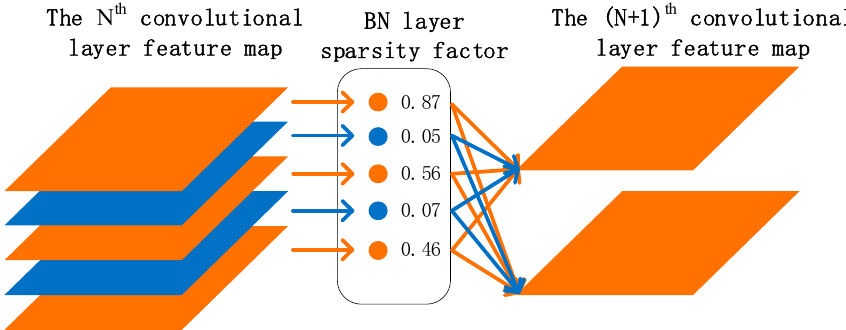
Figure 10. Schematic diagram of pruning.